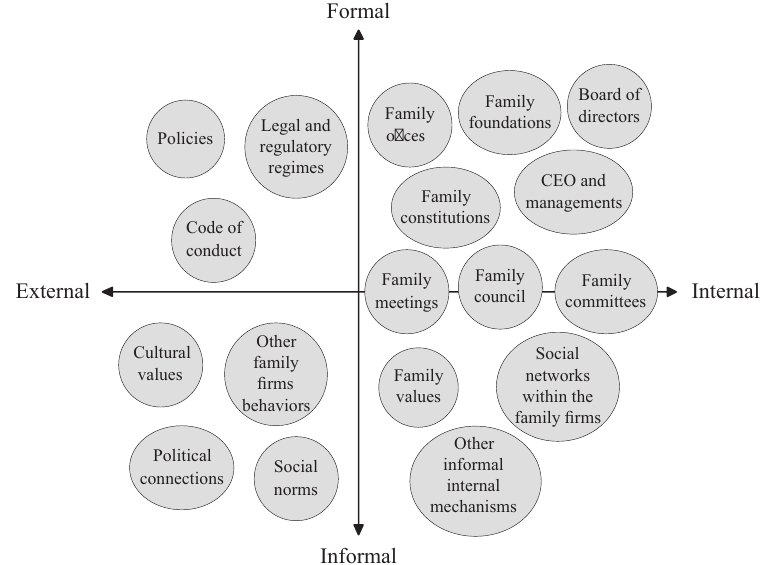
Figure 1. The classification of